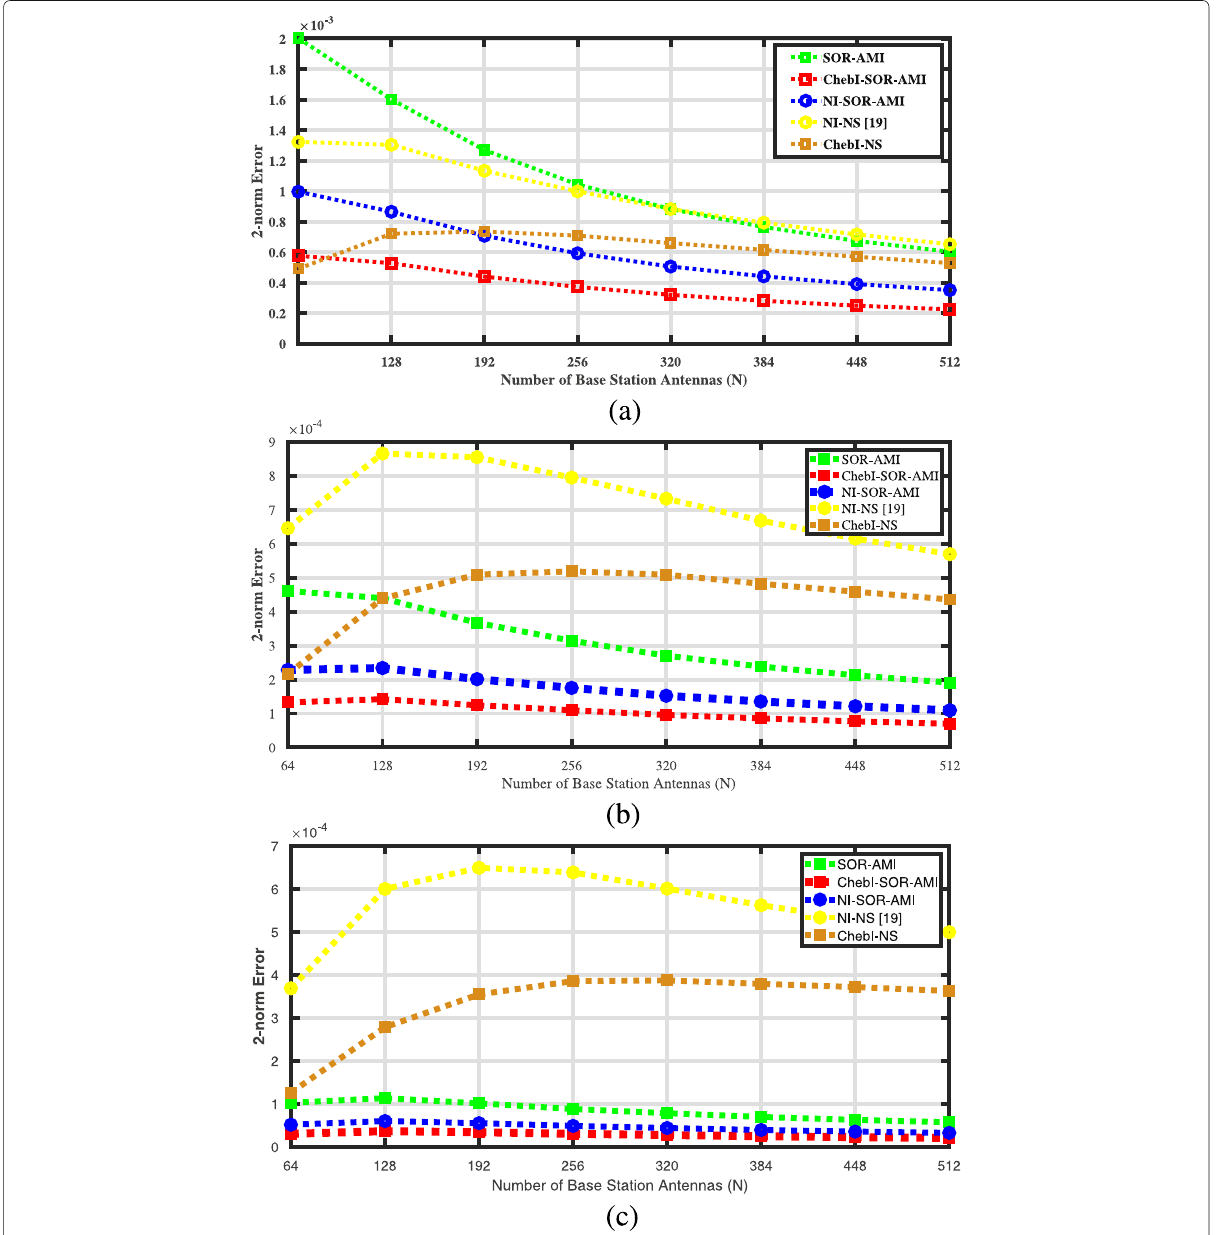
Fig. 2 MSE of ChebI-NS, NI-NS, SOR-AMI, ChebI-SOR-AMI, and NI-SOR-AMI methods versus number of BS antennas ( N ) for uncorrelated channel at the second, third, and fourth iterations, respectively. This figure computes the MSE of four approximate matrix inversion techniques for uncorrelated channel conditions under second, third, and fourth iterations, respectively. a iteration, i = 2. b iteration, i = 3. c iteration, i = 4